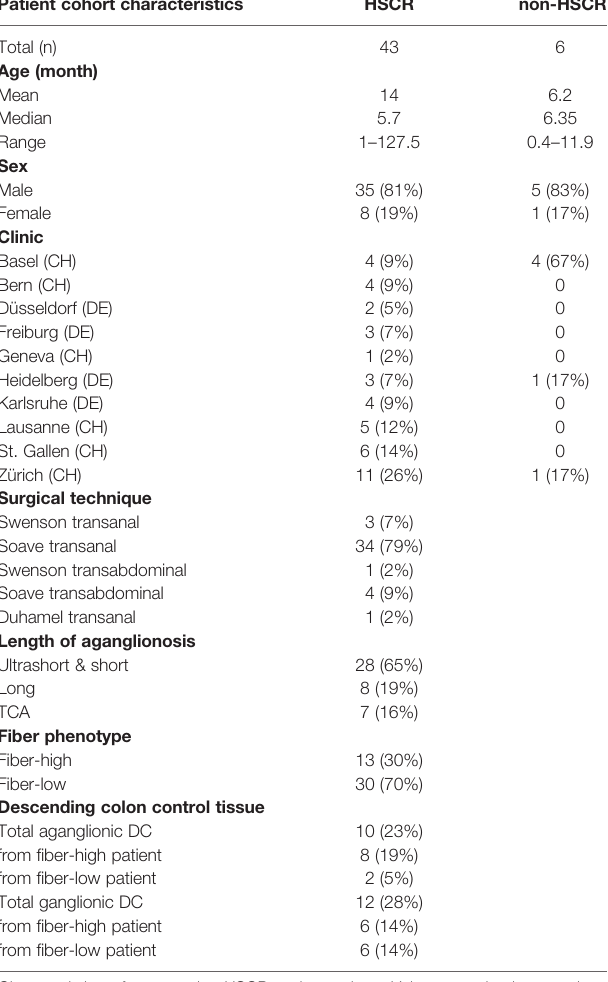
TABLE 1 | Patient